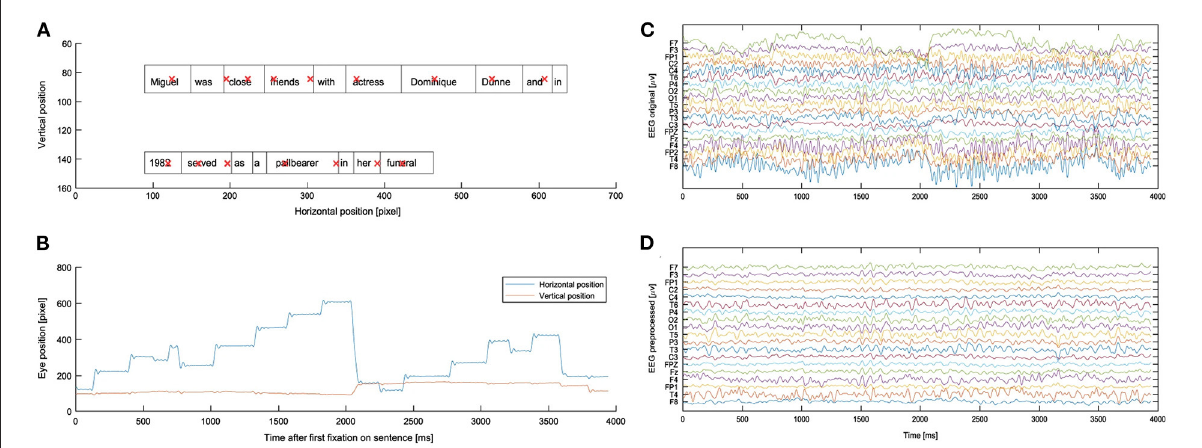
FIGURE3 Visualization of eye-tracking and EEG data for a single sentence. (A) Prototypical sentence fixation data. Red crosses indicate fixations; boxes around the words indicate the wordbounds. (B) Fixation data plotted over time. (C) Raw EEG data during a single sentence. (D) Same data as in (C) after